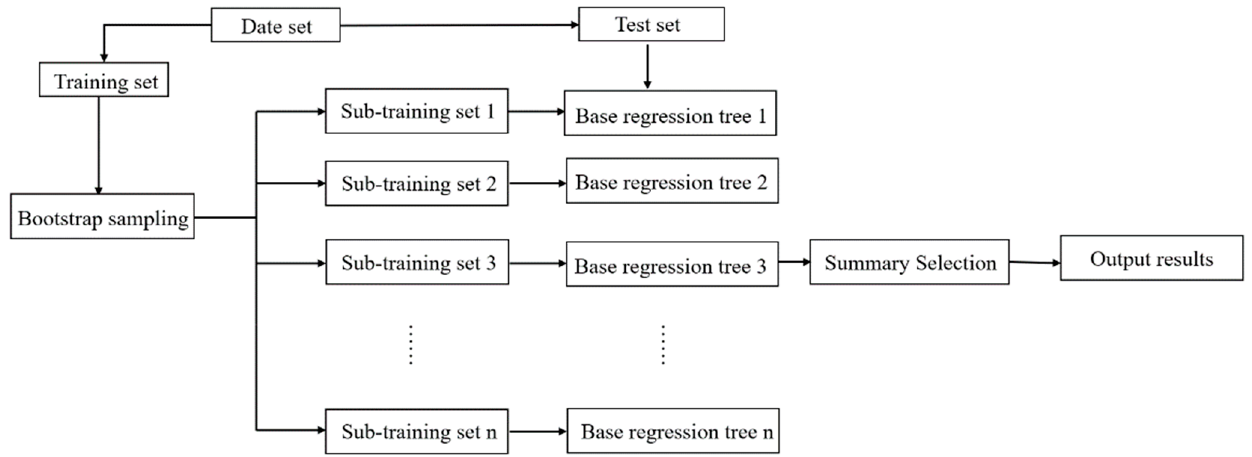
Figure 8. Schematic diagram of the random forest algorithm model.